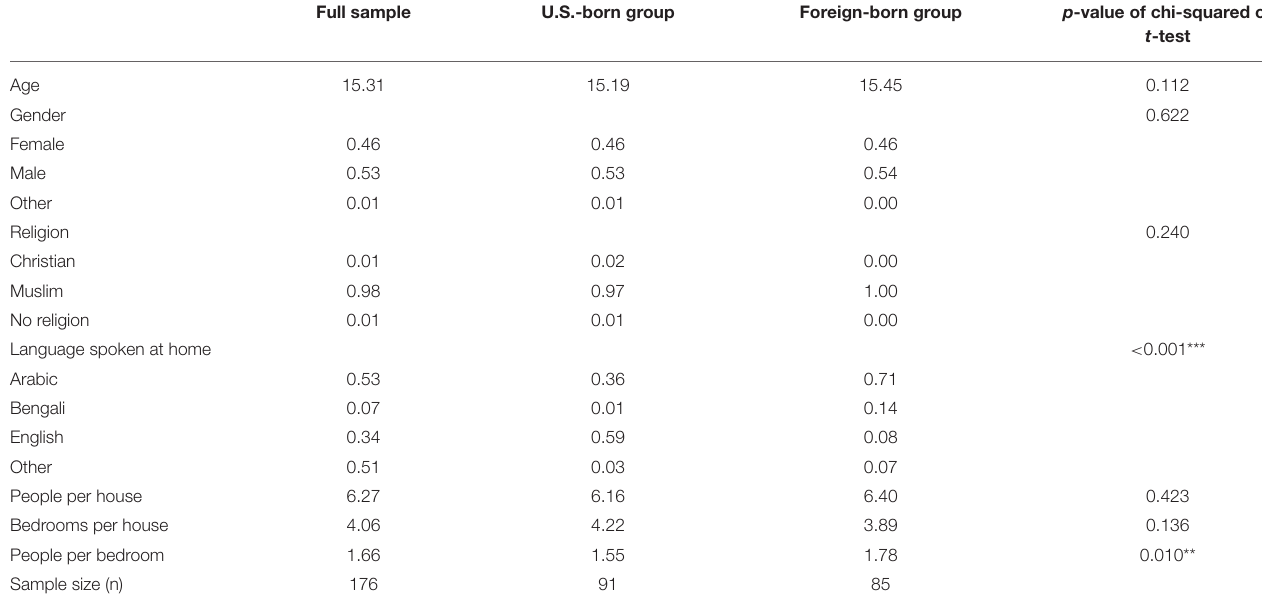
TABLE 3 | Basic demographics of